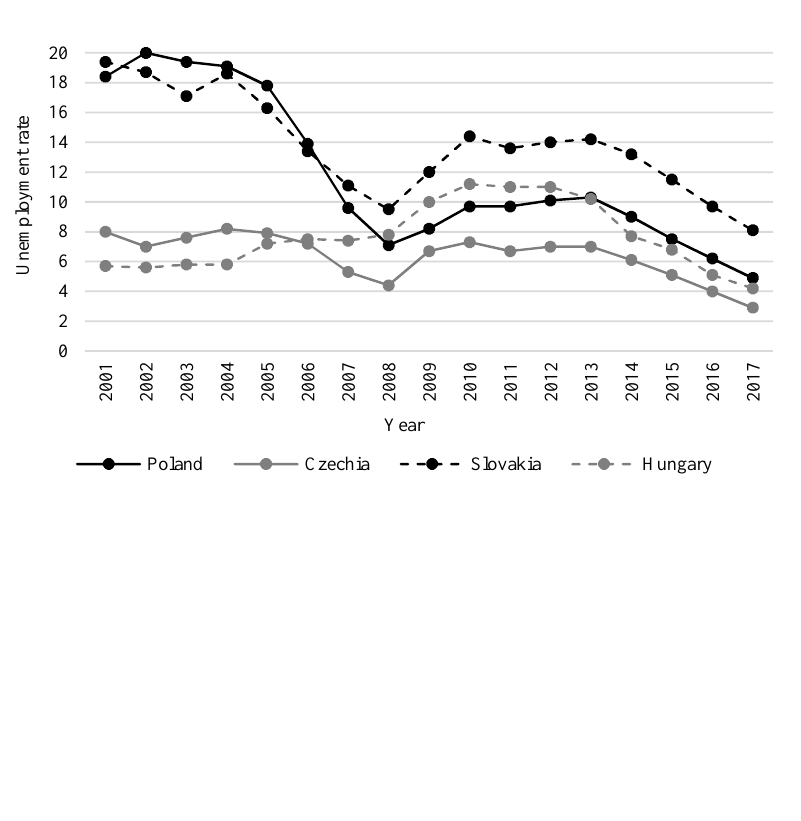
Figure 1. Unemployment rate in the Visegrad Group countries in years 2001–